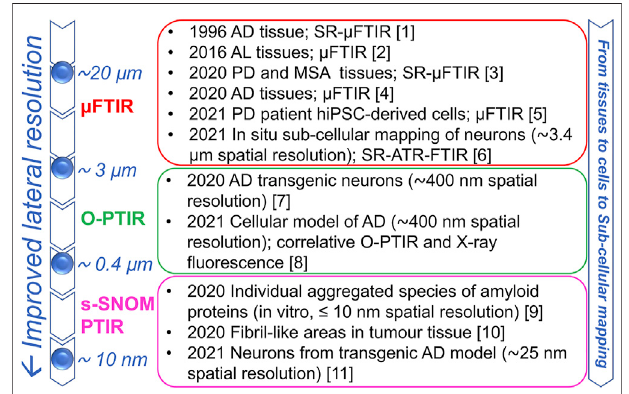
FIGURE 1 | Infrared spectroscopy approaches: from the micro- to the nano-scale characterization of biological samples. The lateral resolutions and selected examples for the in situ study of protein aggregation are reported for differentIRapproaches.Theincreasedresolutionenablescharacterizing protein aggregates in complex systems from tissues, to intact cells and to sub-cellular areas. References: (1) Choo et al., 1996; (2) Ami et al., 2016; (3) Arakietal.,2020;(4)Röhretal.,2020;(5)Gustavssonetal.,2021a;(6)Hartnell et al., 2021; (7) Klementieva et al., 2020; (8) Gustavsson et al., 2021b;